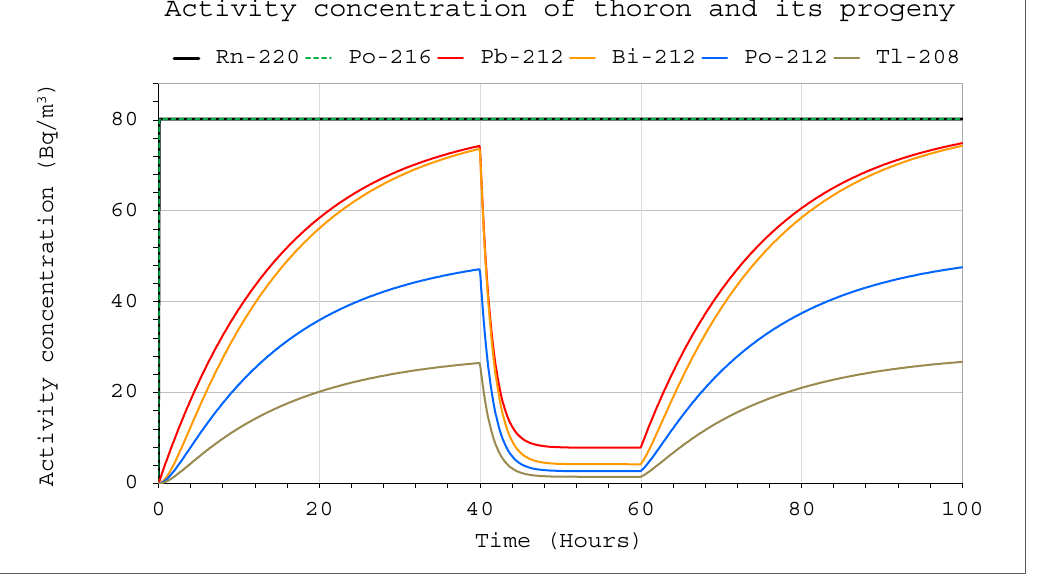
Figure 9. Activity concentration of thoron and its progeny inside the system for the following conditions: inflow of thoron throughout the analyzed period at a rate of E 1 = 1 Bq/s, V = 20 m 3 , C oi = 0. The filtration system was operating in the range of 40–60 h with a flow rate of Q D = 10 L/min and a filtration efficiency of F = 100%.